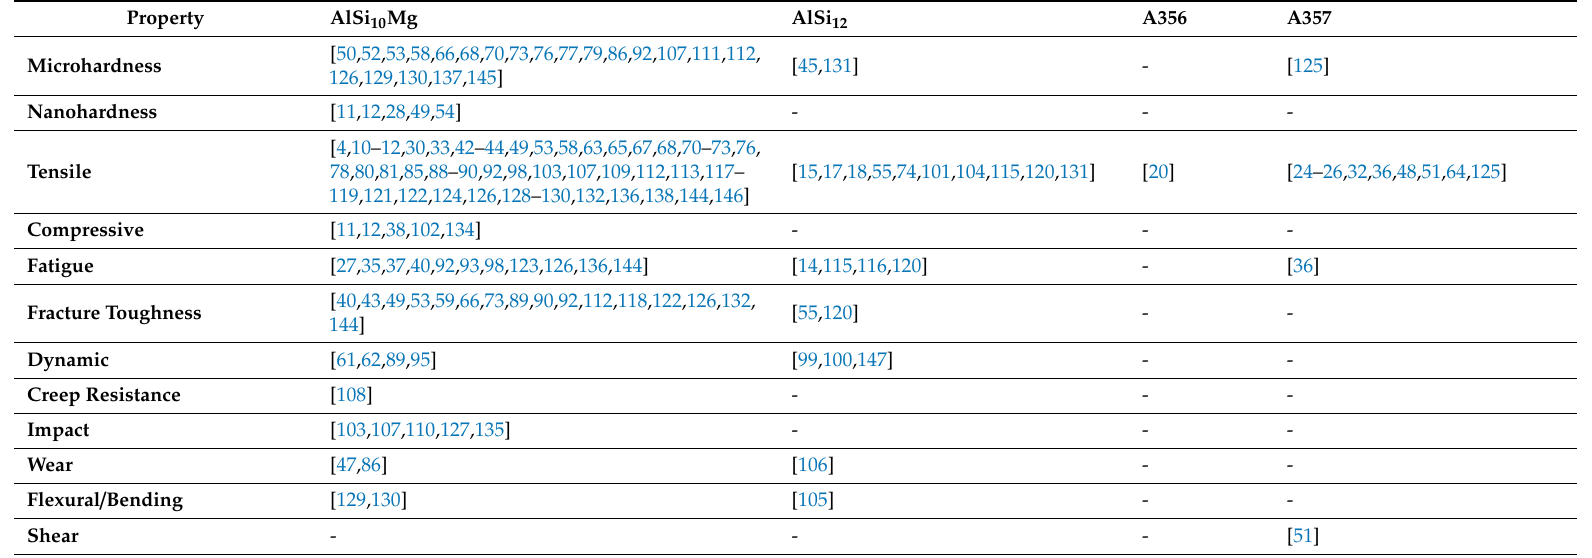
Table 3. List of studies evaluating various mechanical properties of SLM-printed Aluminium